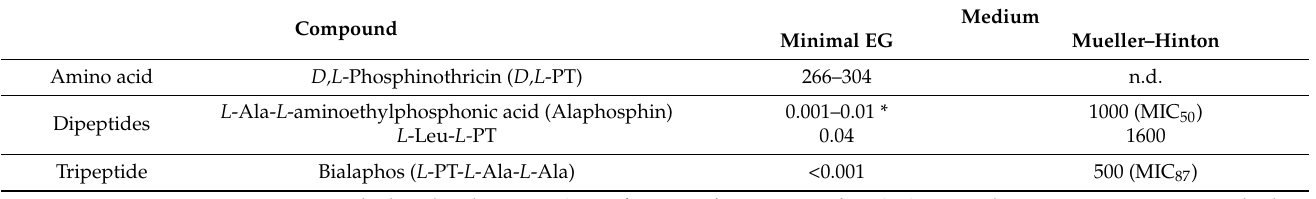
Table 1. Minimum inhibitory concentration (MIC 90 , µ g/mL) of the compounds tested on E. coli